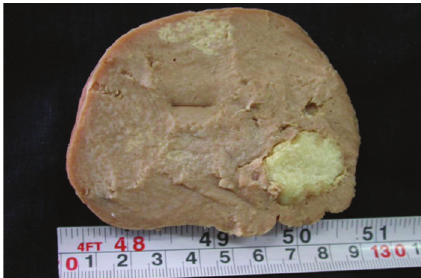
Figure 2: Enlarged axillary lymph node shows areas of ossification.